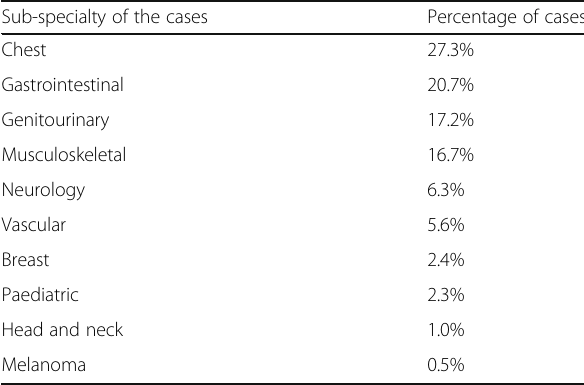
Table 4 Sub-speciality of the cases discussed in the educational